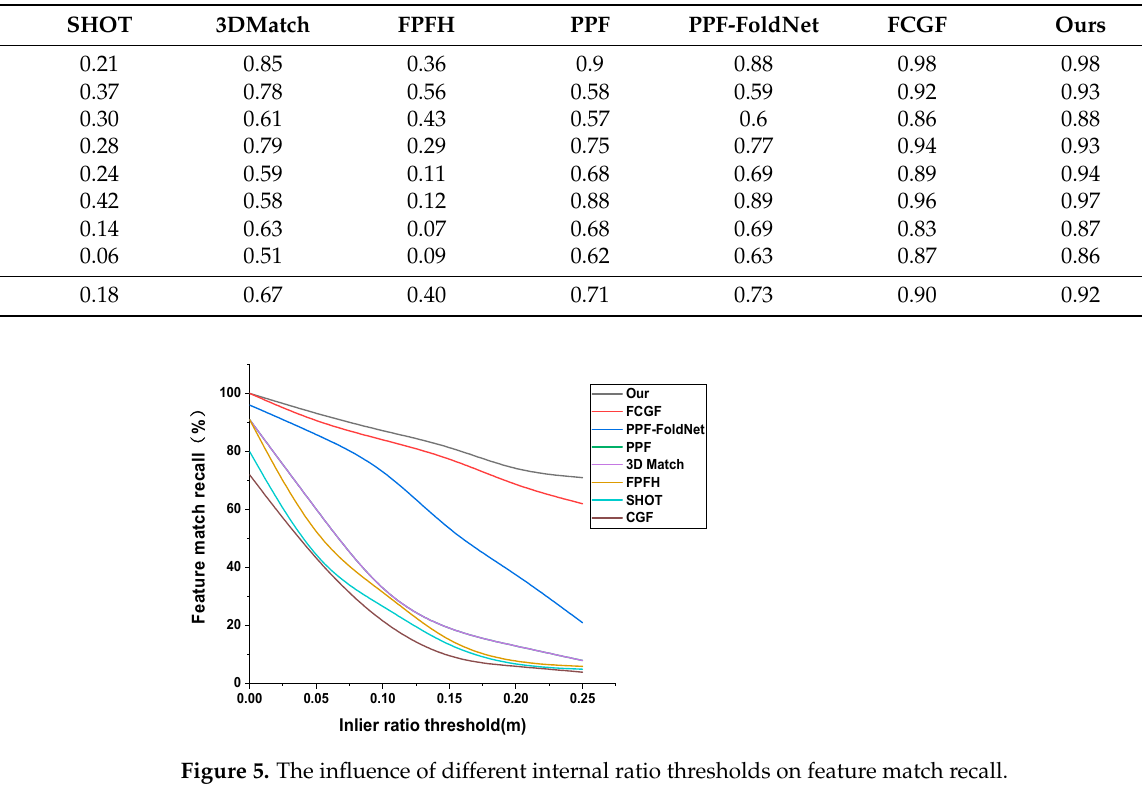
Table 2. The recall of different fixed radius and gradient radius in the Home1 category of 3DMatch.